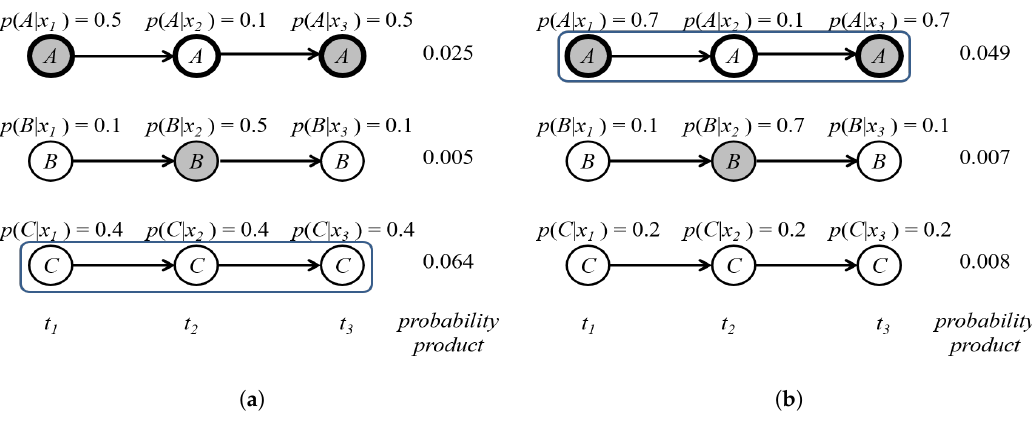
Figure 17. Examples of how MLCS performs: ( a ) missclassification and ( b ) correct output. Ground truth (circles with thick borders); maximum probability classes on each date (shadowed circles); final MLCS outcome